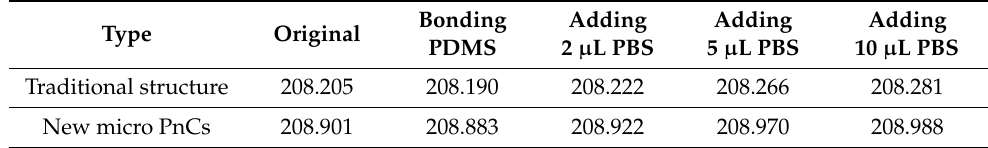
Table 1. Center frequency of the delay line